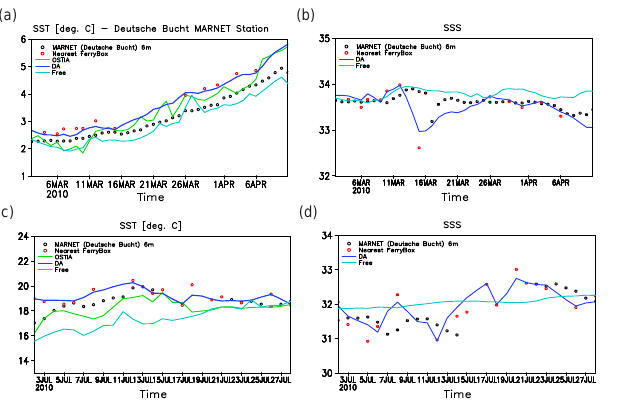
Fig. 14. Comparison of simulated SST (a, c) and SSS (b, d) from F IG . 14. Comparison of simulated SST (a,c) and SSS (b,d) from the Free Run and DA Run analysis fields against MARNET observations at Deutsche Bucht Station, located at the Free Run and DA Run analysis fields against MARNET obser- 54.17 0 N, and 7.45 0 S. vations at Deutsche Bucht Station, located at 54.17 ◦ N, and 7.45 ◦ S.